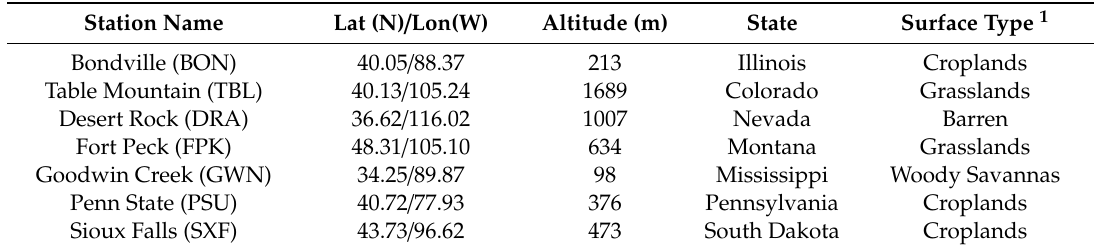
Table 1. Seven stations of land-surface temperature (LST) measurements selected from the surface radiation budget network (SURFRAD).